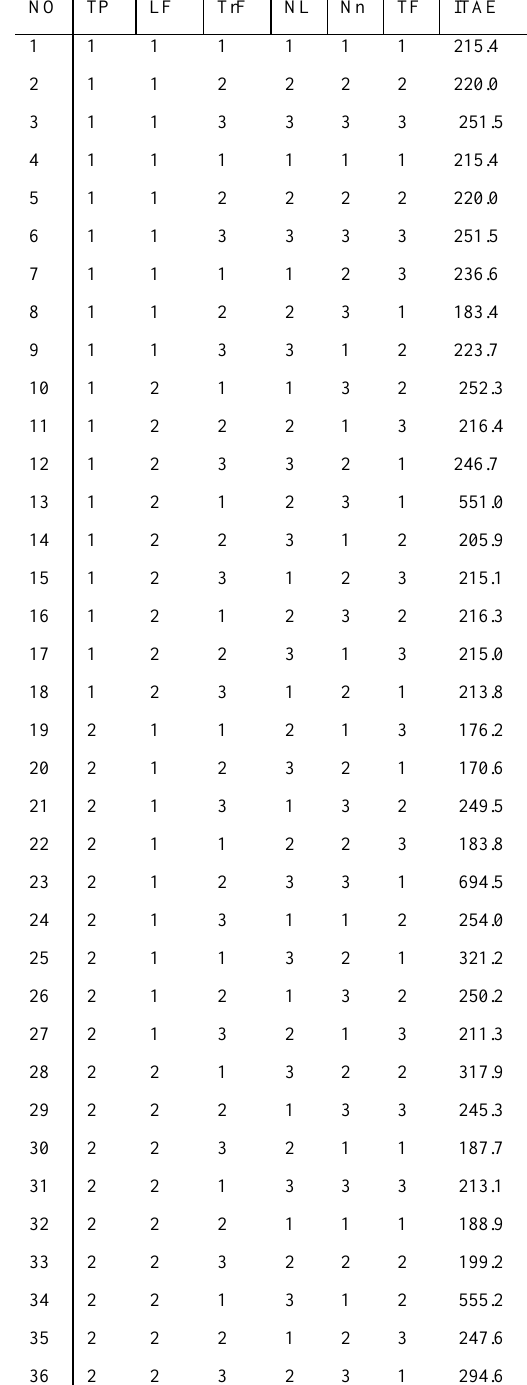
Table 3. Orthogonal for different factors of